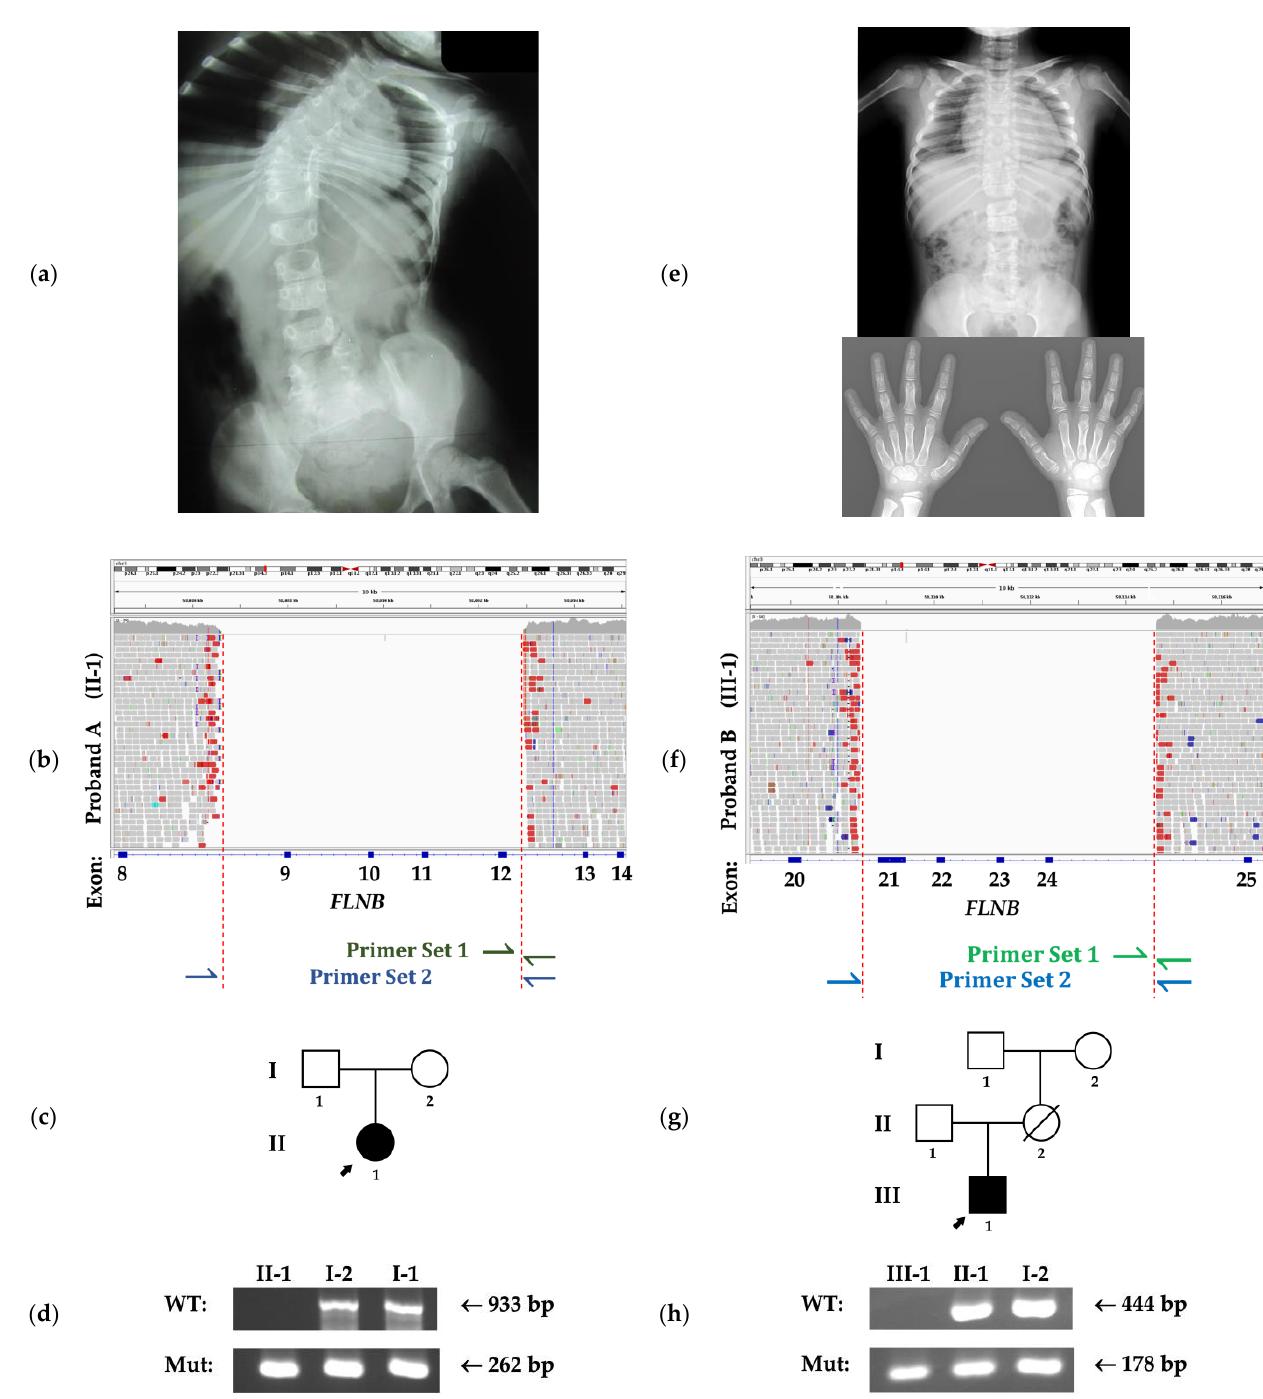
Figure 1. Radiographs and sequence data from families A and B. ( a ) Spine X-ray of proband A at age 6 showing fusions of T3 – T11 vertebrae and significant scoliosis. ( b ) IGV plot showing the novel homozygous deletion in proband A that removes exons 9 – 12 of FLNB . The positions of the primers used for the allele-specific PCR are indicated underneath. ( c ) Pedigree of family A. ( d ) PCR results from family A demonstrates the absence of the wild-type (WT) allele and the presence of the deletion-containing allele (Mut) in the proband (II-1) while the parents (I-1, I-2) have both WT and Mut alleles. ( e ) X-rays of proband B at age 9 showing fusions of T6 – T9 vertebrae and capitate – hamate fusion bilaterally. ( f ) IGV plot showing the novel homozygous deletion in proband B that removes exons 21-24 of FLNB . The positions of the primers used for the allele-specific PCR are indicated underneath. ( g ) Pedigree of family B. ( h ) PCR results from family B showing the absence of the WT allele and the presence of the deletion-containing allele in the proband (III-1), while both alleles are found in the father (II-1) and the maternal grandmother (I-2).